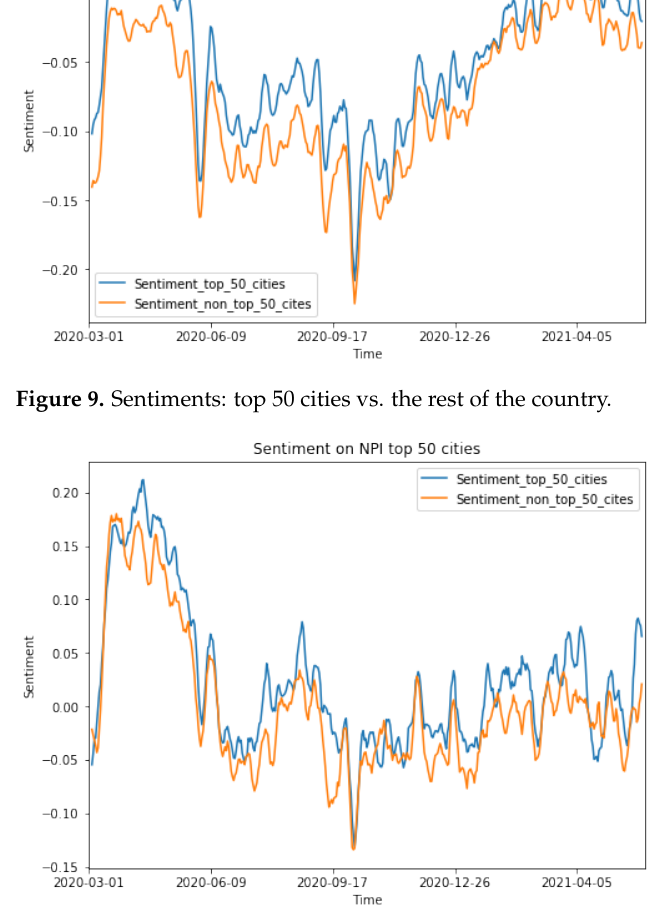
Figure 10. Sentiments towards NPIs: top 50 cities vs. the rest of the country.